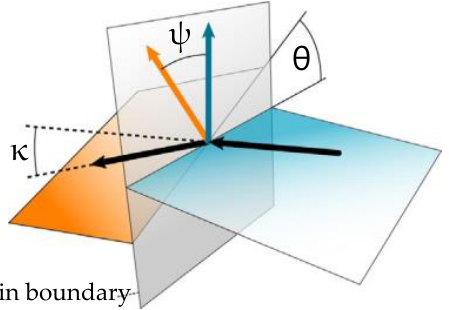
Figure 4. Geometry of slip transfer across a grain boundary [86].